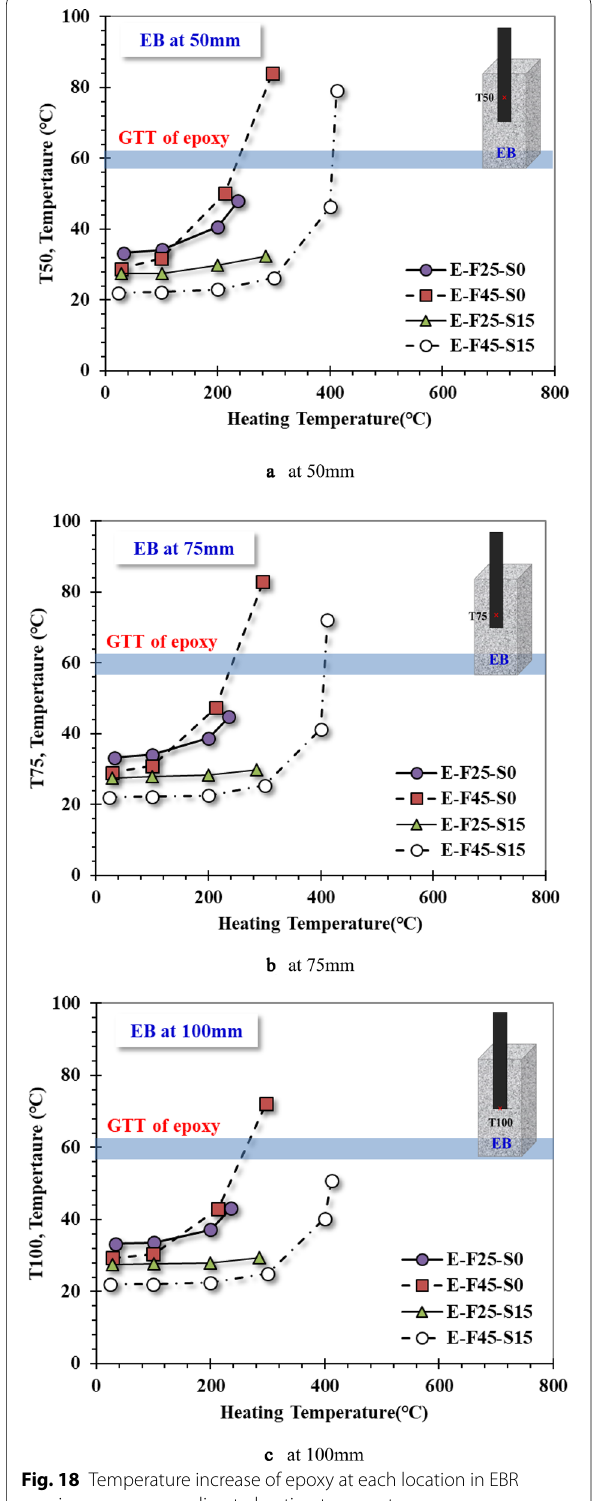
Fig. 18 Temperature increase of epoxy at each location in EBR specimens corresponding to heating